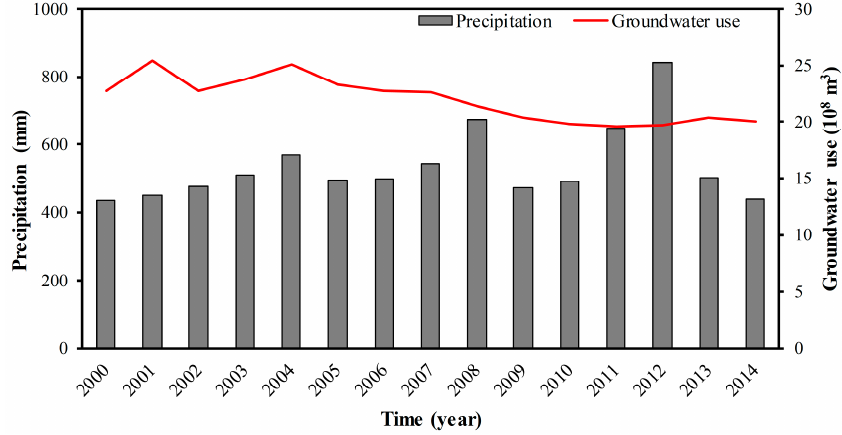
Figure 5. Changes in precipitation and groundwater use in the Beijing Plain.